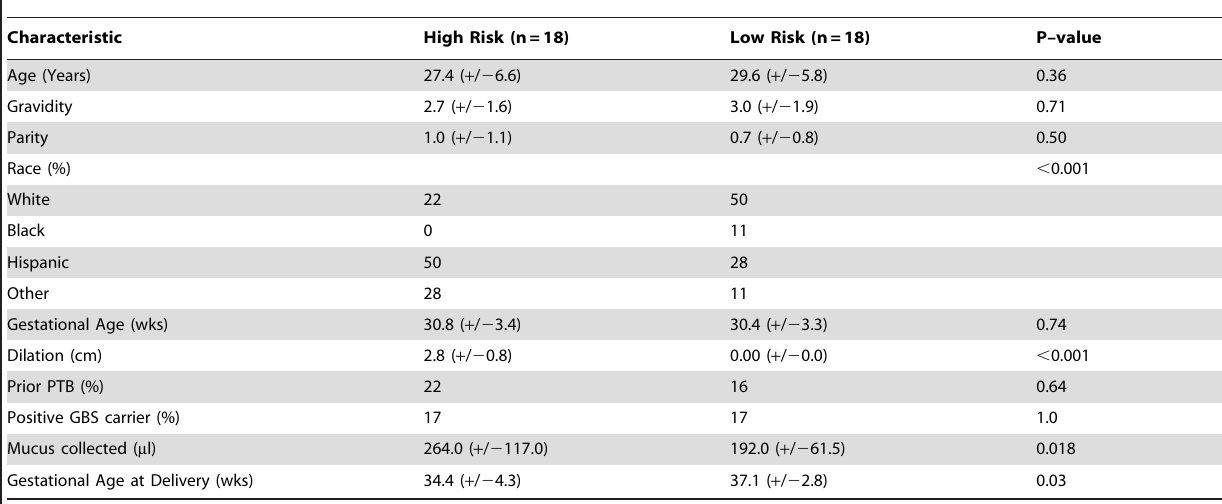
Table 1. Patient